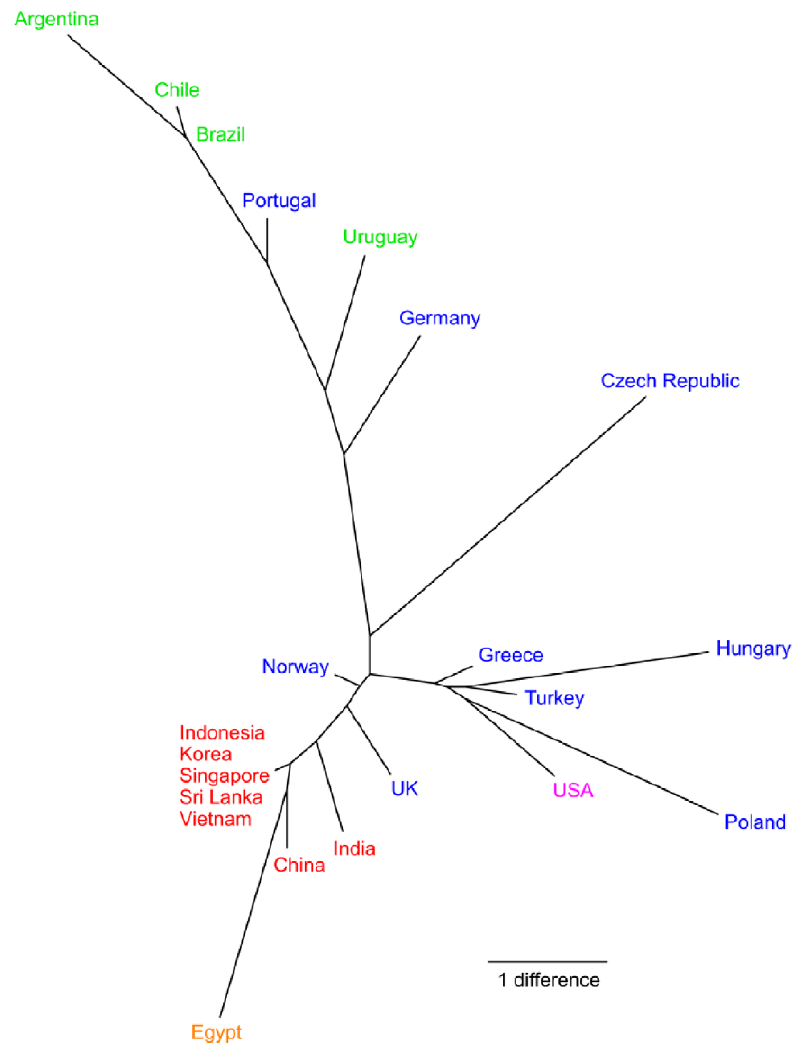
Figure 2. Geographic structure within the ST239 clonal group. Tree is a neighbor-joining population tree based on the average number of pairwise nucleotide differences between countries. Labels are colored according to